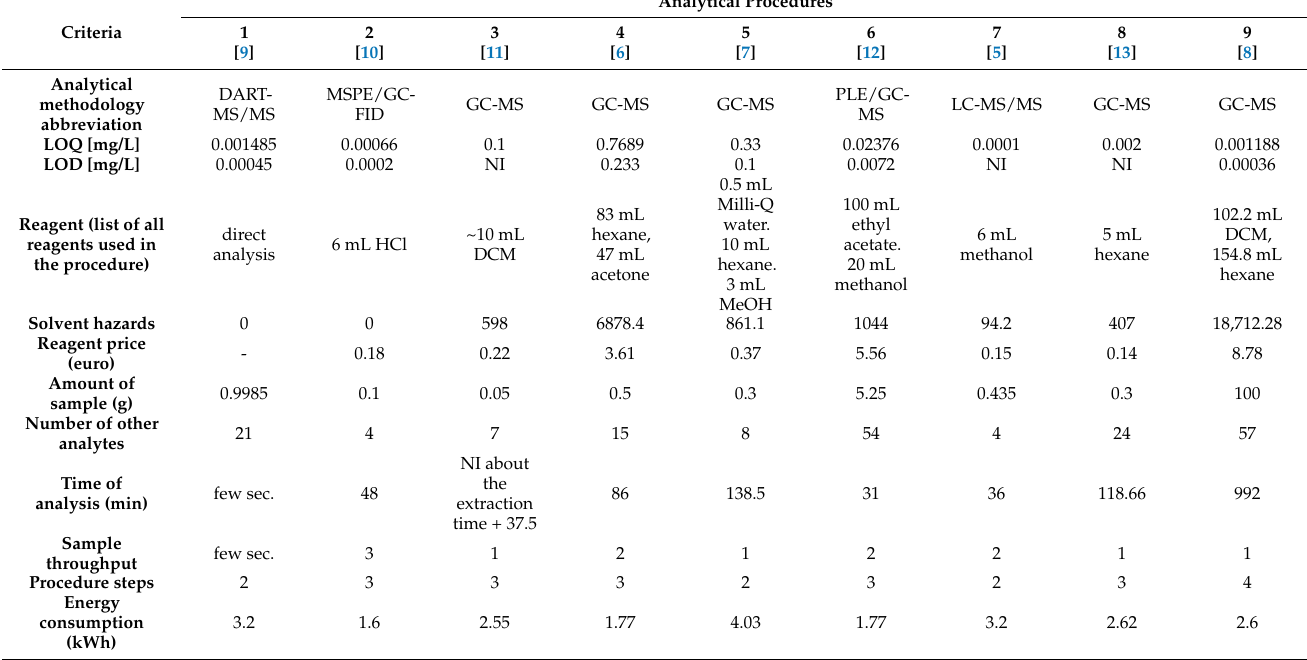
Table 1. Dataset characteristics.